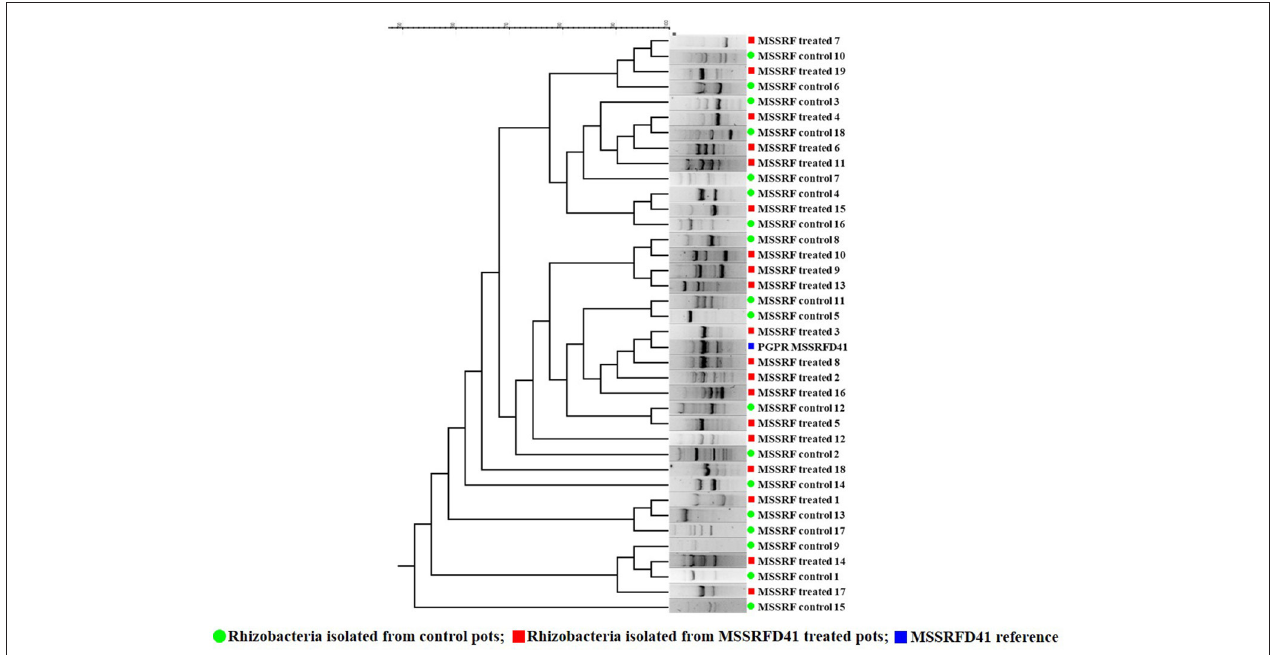
FIGURE 3 | Genomic fingerprinting to evaluate MSSRFD41 colonization and survival.